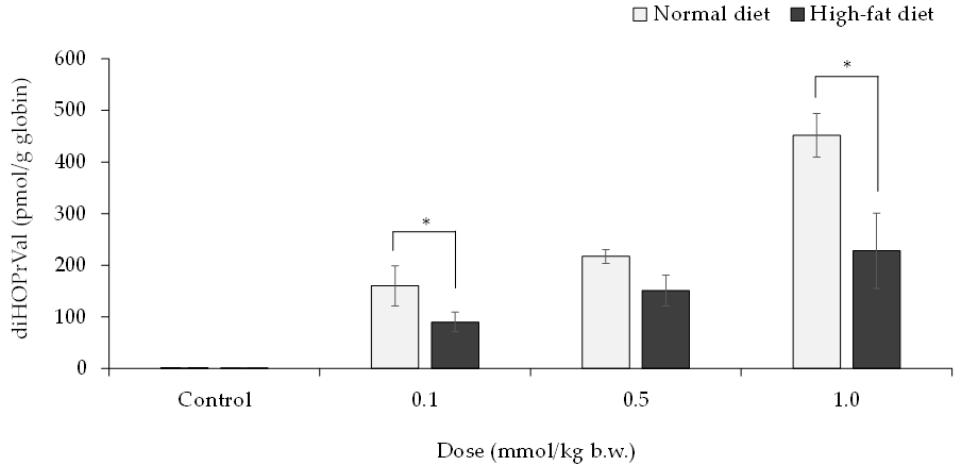
Figure 5. Effect of high-fat diet on glycidol–Hb adduct diHOPrVal formation. GEs (0, 0.1, 0.5, and 1 mmol/kg b.w.) were administered orally on day 59 of the high-fat diet, and diHOPrVal blood was measured by LC–MS/MS. The values represent the mean ± standard deviation (SD) of independent experiments on five mice. * The significance level was p < 0.05 compared with normal diet.